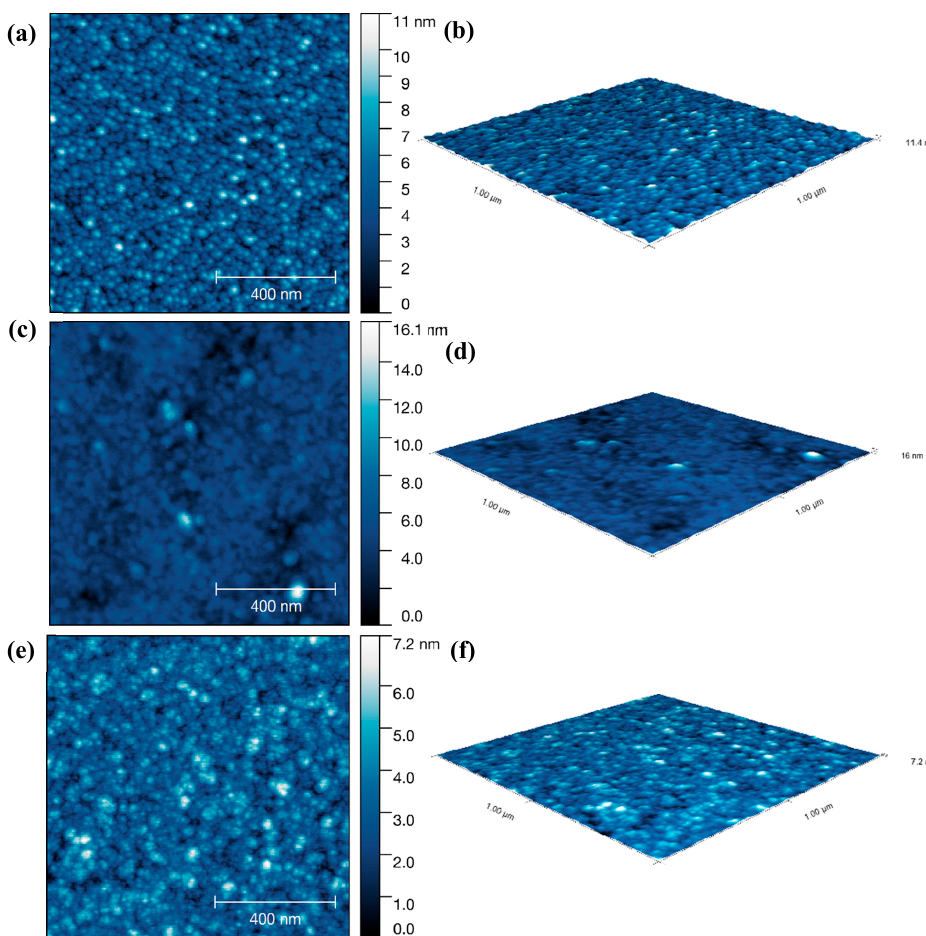
Figure 6. AFM scans and 3D images of Al 2 O 3 films after 250 ALD cycles, on ( a , b ) silicon; ( c , d ) quartz; ( e , f ) glass. A cycle includes 2.5 s ATSB pulse, 3 min Ar purge, 2 s H 2 O pulse and 3 min Ar purge, deposition temperature 200 °C, gas flow rate 120 sccm.